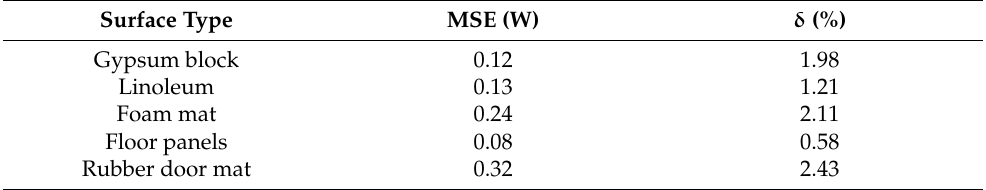
Table 4. The calculated values of quality factors for the mathematical model of the differential drive robot. Surface